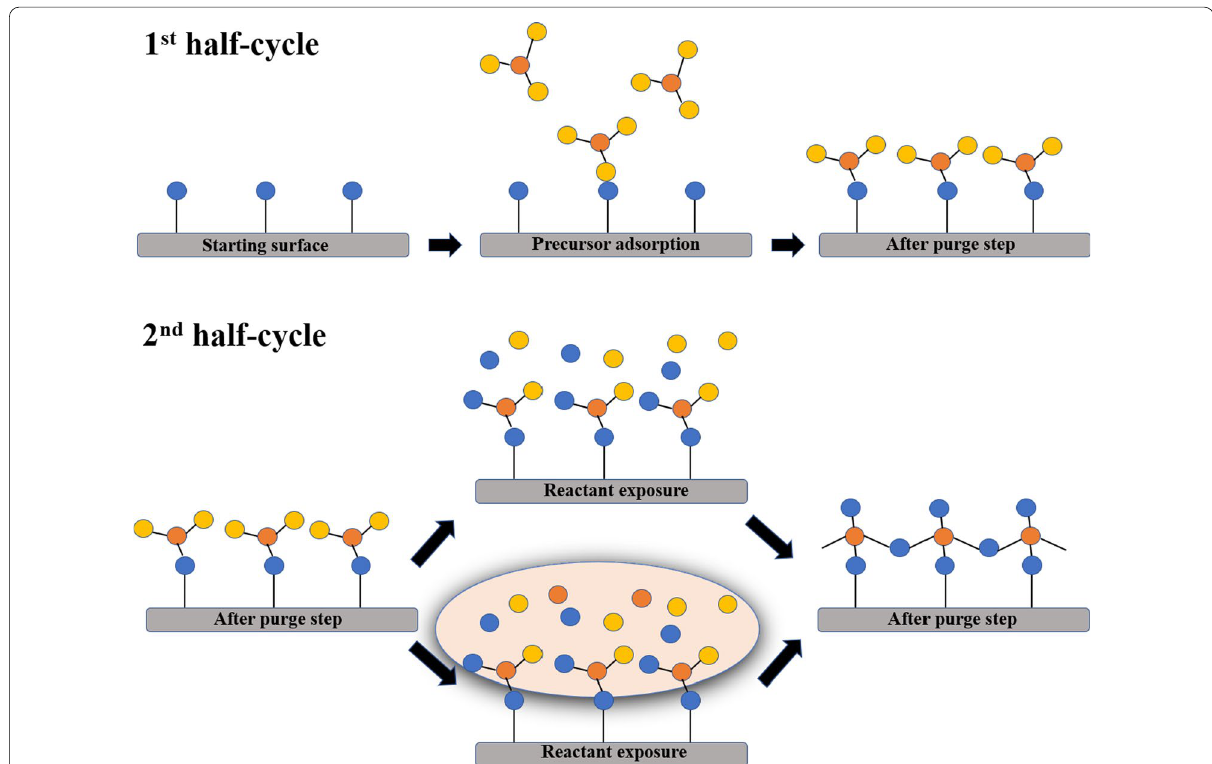
Fig. 1 Schematic representation of thermal and plasma‑assisted